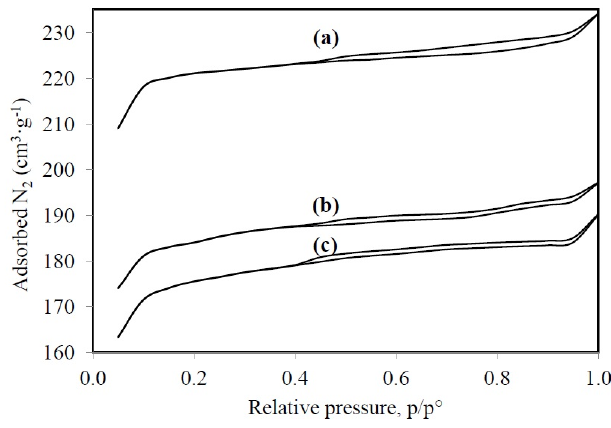
Figure 3. Adsorption and desorption isotherms for ( a ) HY zeolite; ( b ) LaY and ( c ) Pd/LaY catalysts.